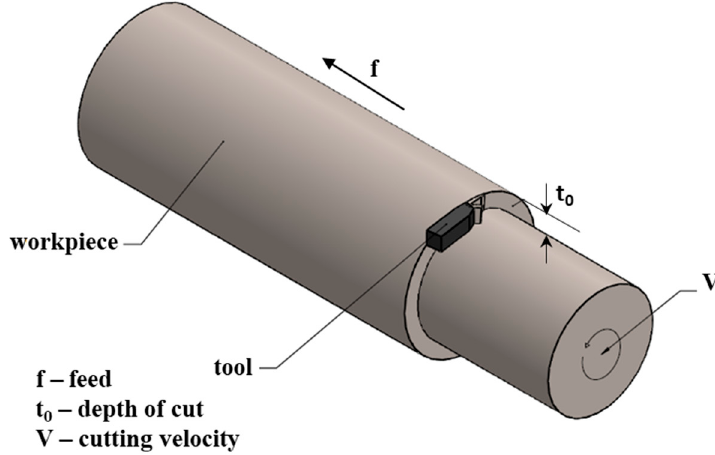
Figure 1. Schematic representation of machining process.